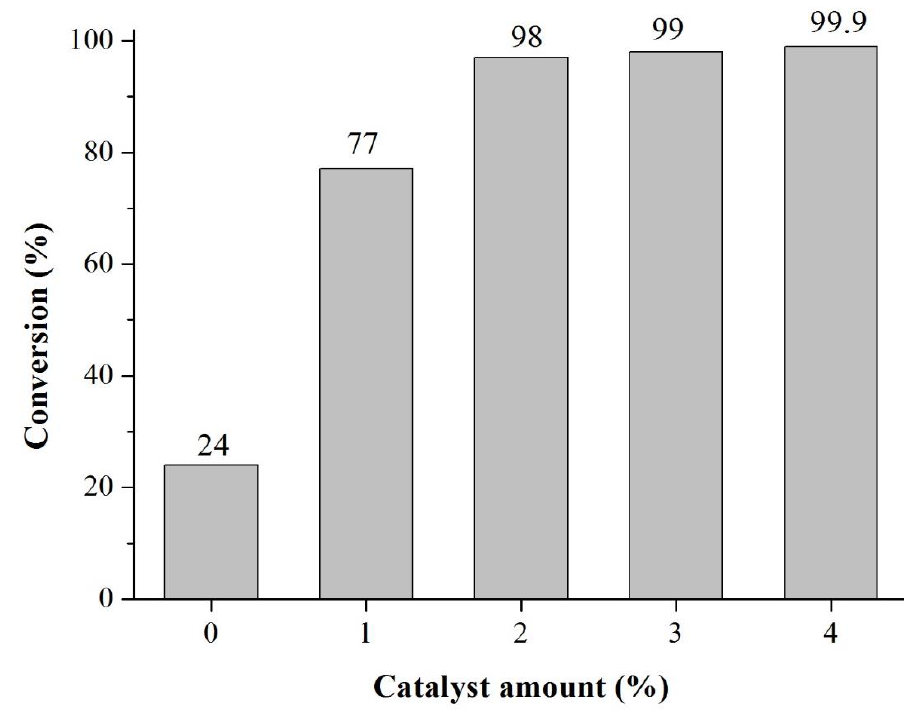
Figure 7. Percentage conversions of eugenyl acetate with different amount of catalyst. Reaction